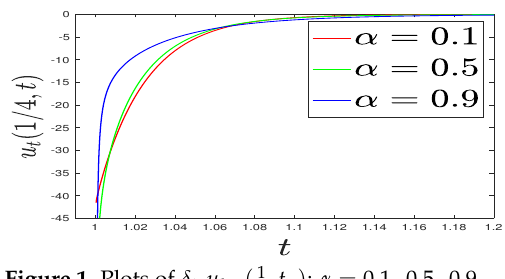
Figure 1. Plots of δ t